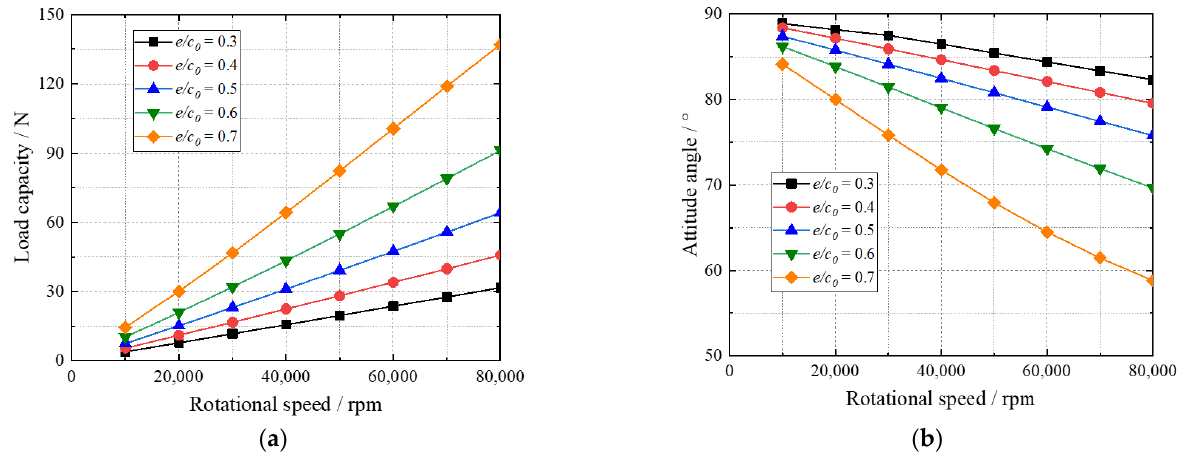
Figure 15. ( a ) Bearing load capacity and ( b ) attitude angle of hydrogen gas bearings with eccentricity ratio. ity ratio.